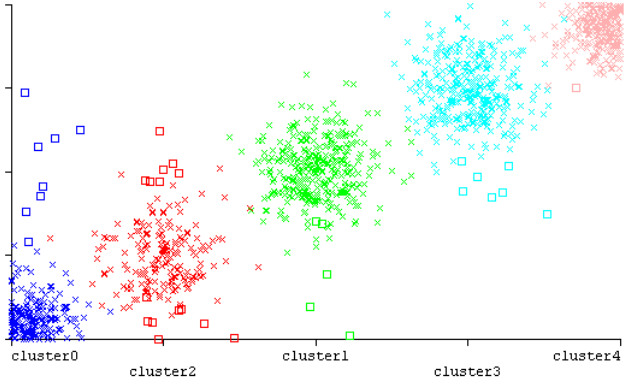
Figure 11. Predictions for EEG electrons based on the logistic regression classifier (electron 1)